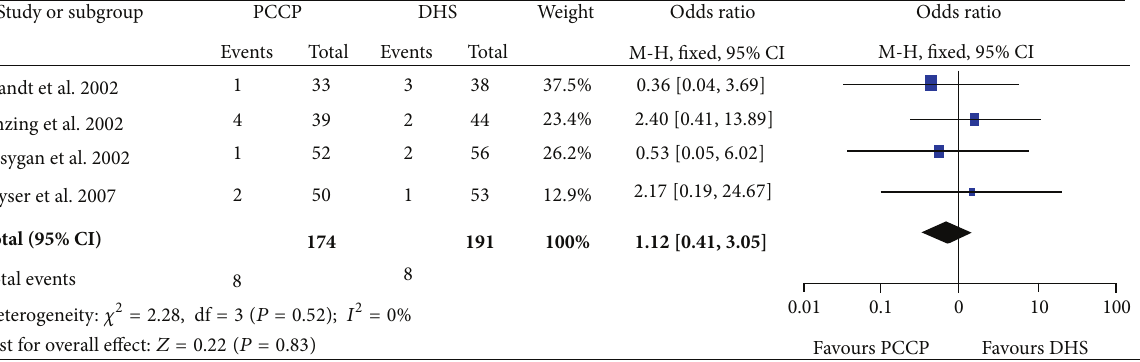
Figure 8: Comparison of reoperation between PCCP and DHS.